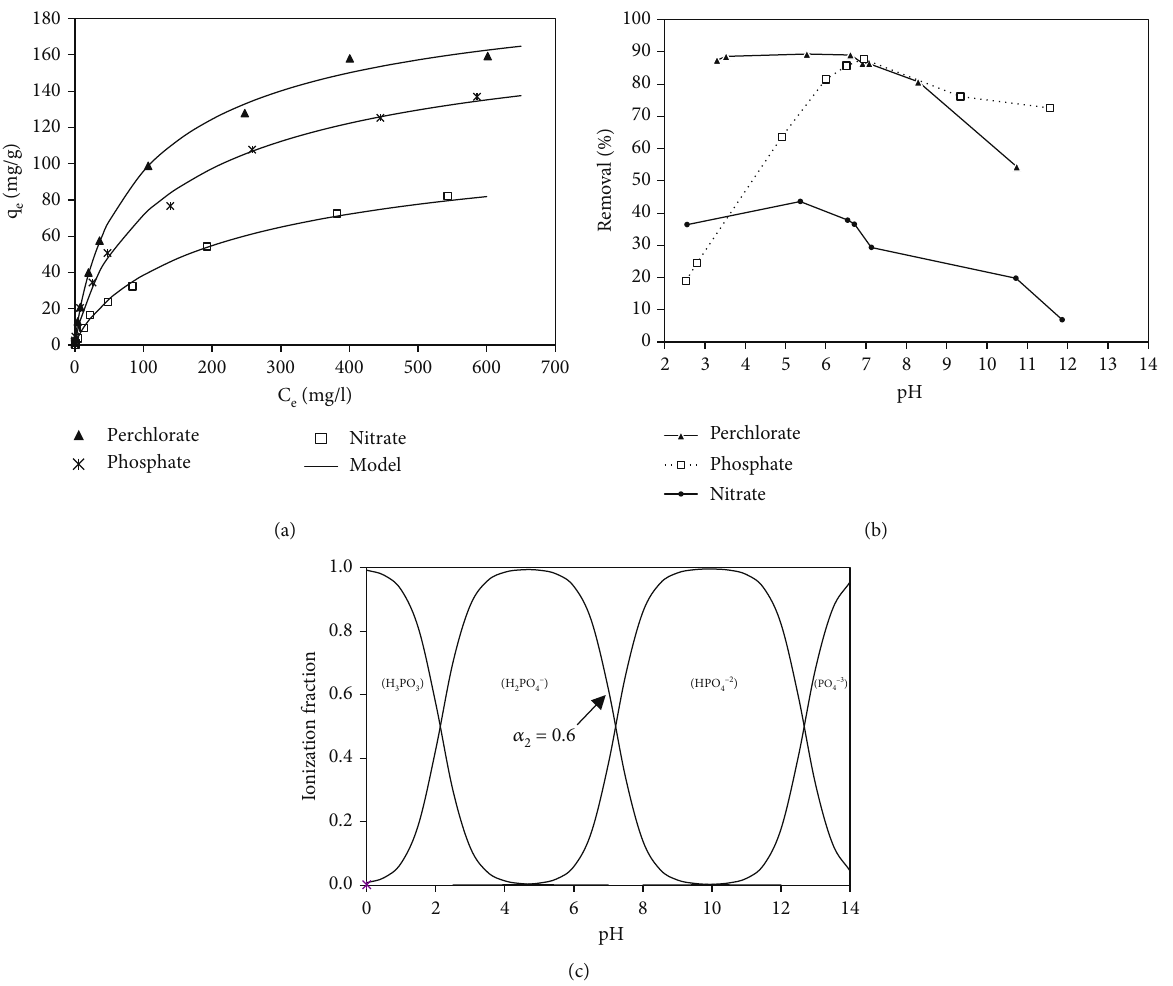
Figure 1: Isotherm and pH e ff ects on MR adsorption of nitrate and phosphate. (a) Adsorption of anions by MR (2.0 g/L) and the fi tted L-F isotherm model at pH 7 : 0 ± 0 : 5 with a contact time of 24 h. (b) E ff ect of pH on anion removal by MR. Initial ½ ClO −  = 250 mg/L; initial ½ PO 43 −  = 50 mg/L; temperature = 25 ° C. (c) Phosphate speciation diagram as a function of pH in solution at an NO 3 ionic strength of 0.01M. At pH of 7 : 0 ± 0 : 5 , phosphate is present as H Table 2: Hydrated radius of common anions from Moyer and Bonnesen [29].